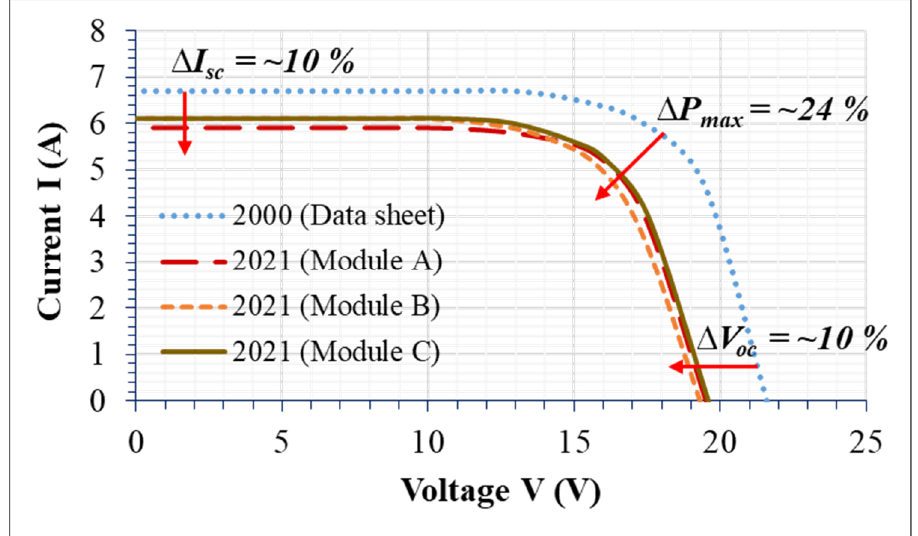
Figure 4. Normalized I-V characteristics of the 3 old PV panels (A, B, C). The data sheet curve by the manufacturer in the year 2000 is also shown.